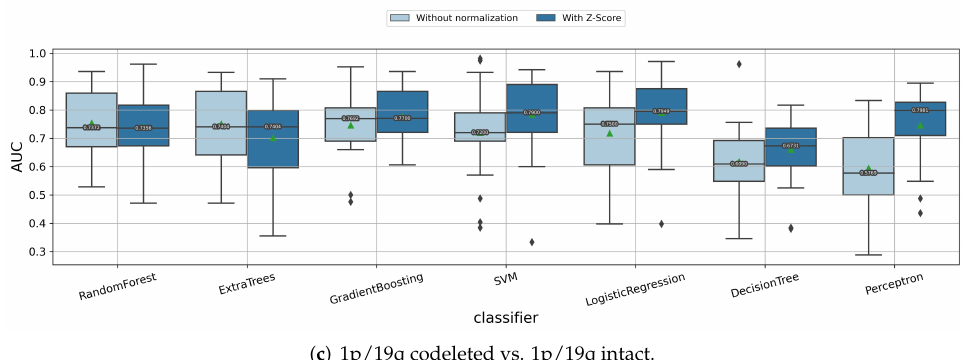
Figure 3. Impact of the Z-score normalization in predicting ( a ) tumor grade, ( b ) IDH mutation status, and ( c ) 1p/19q codeletion status.